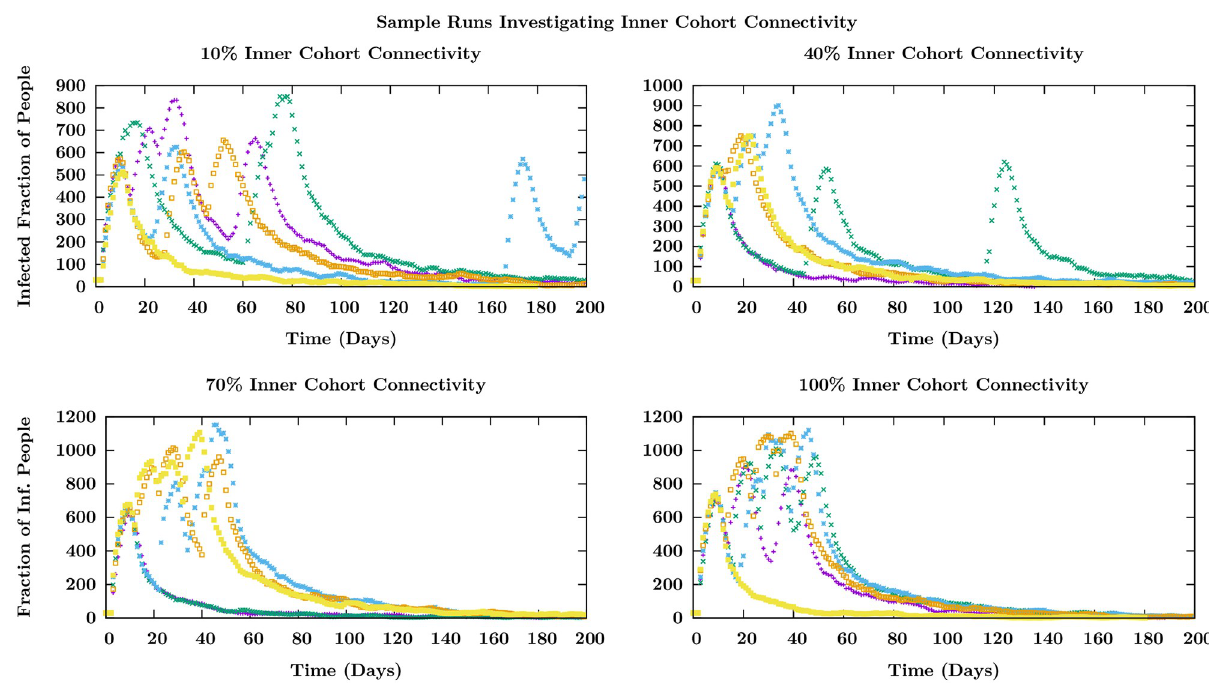
Fig 10. Infectious number as a function of time in several sample runs for varying degrees of inner-cohort connectivity. Different colors indicate individual samples trajectories in time which are started with the same initial condition of 30 infected individuals in the first cohort of 4 in a total population of 6000. The significant change is in the time interval between recurrence peaks as explained in the text.